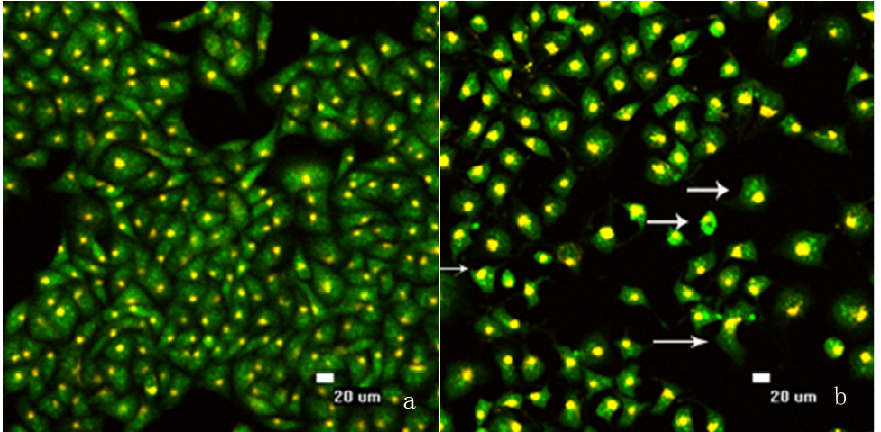
Figure 3. Morphological changes in SMMC-7721 cells treated with B2 for 48 h examined by LSCM. The morphological changes of cells are indicated by arrows. ( a ) Control cells; ( b ) Cells treated with 0.5 nM